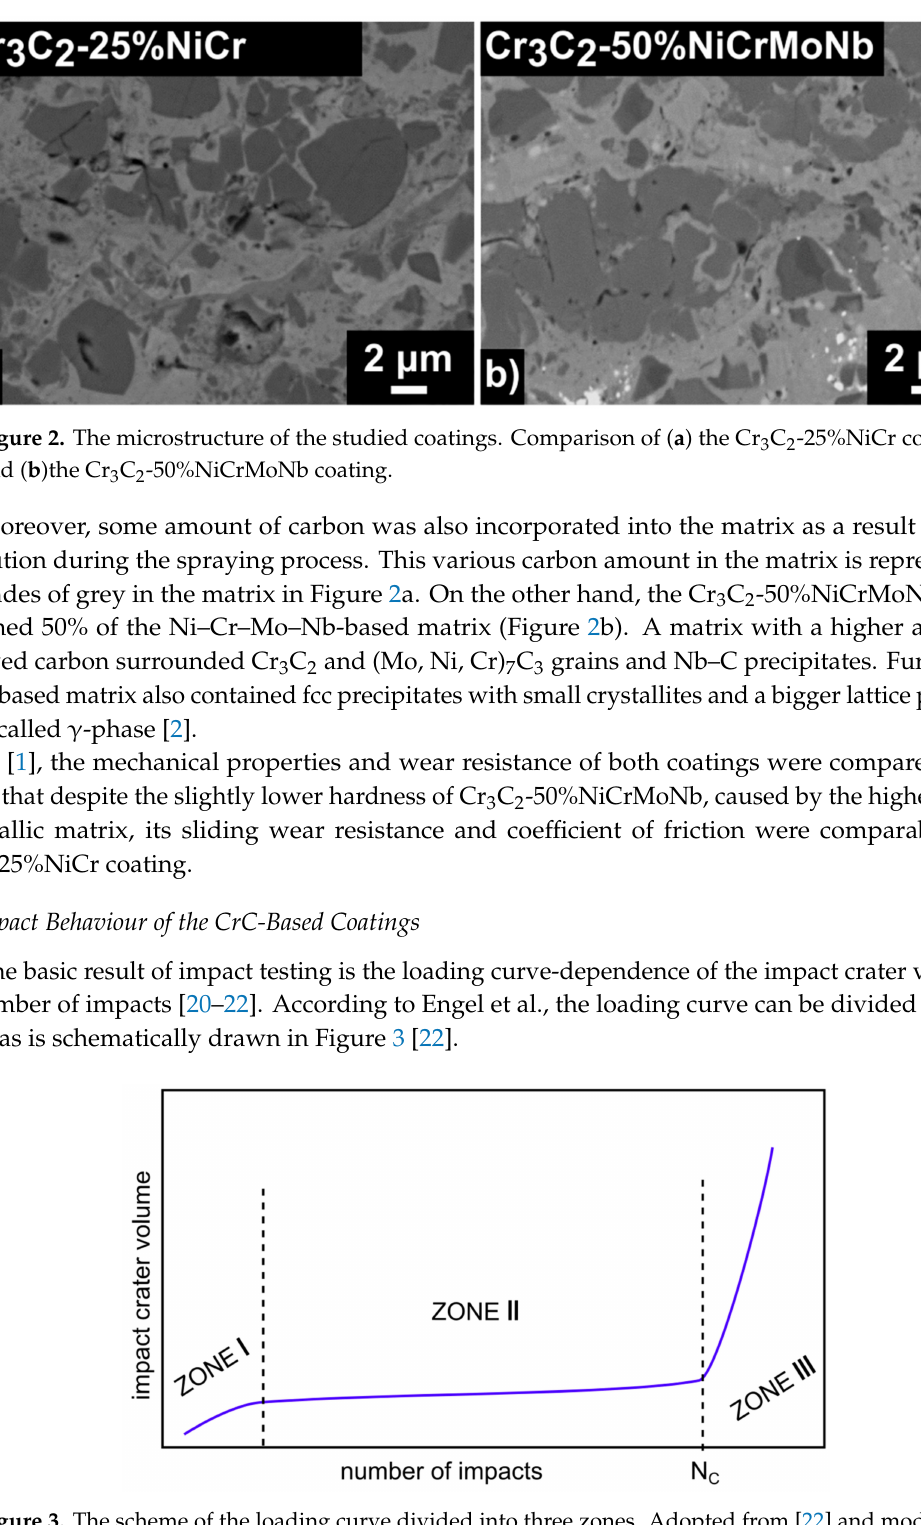
Figure 3. The scheme of the loading curve divided into three zones. Adopted from [22] and